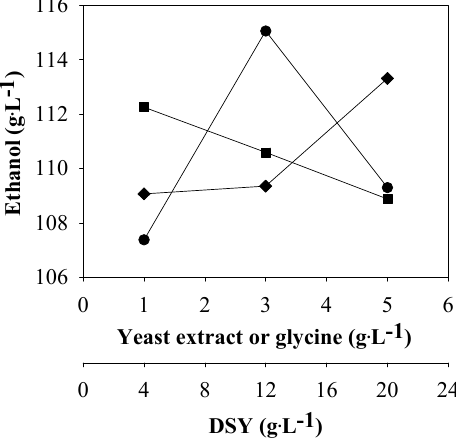
Figure 2. The ethanol concentrations at different levels and factors: yeast extract ( ● ), dried spent yeast (DSY, ■ ) and glycine ( ♦